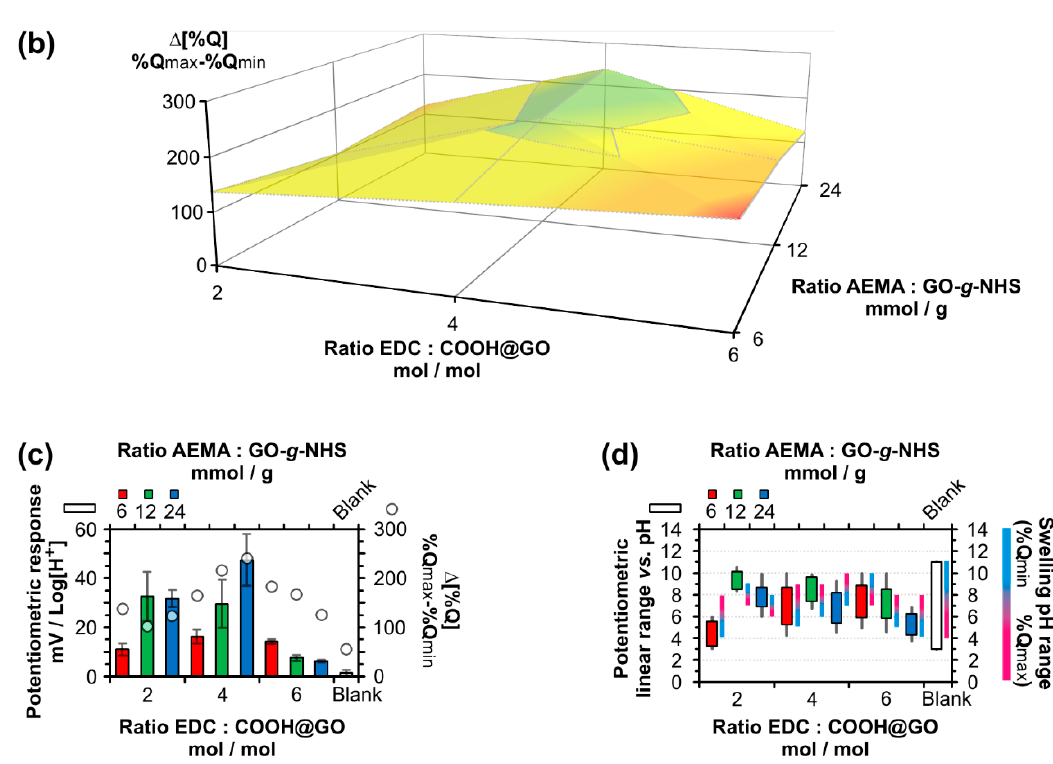
Figure 2. Performance evaluation for the nine di ff erent families of GO- g -poly[DEAEMA] obtained by combinatorial variations in reactant ratios. ( a ) Response surface curve for average potentiometric response against Log[H + ]; ( b ) response surface curve for the di ff erence between maximum and minimum average swelling ratios ( ∆ [%Q] = %Q max – %Q min ) for the same families in ( a ); ( c ) average potentiometric response values against Log[H + ] including 1 s.d. in error bars, and their comparison with ∆ [%Q]; ( d ) average potentiometric linear ranges for response vs. pH including 1 s.d. in error bars, and their comparison with the swelling pH ranges and routes at which minimum-to-maximum average swelling ratios occur. Average values and s.d. are for N = 3; blank materials in ( c , d ) are GO- g -AEMA.